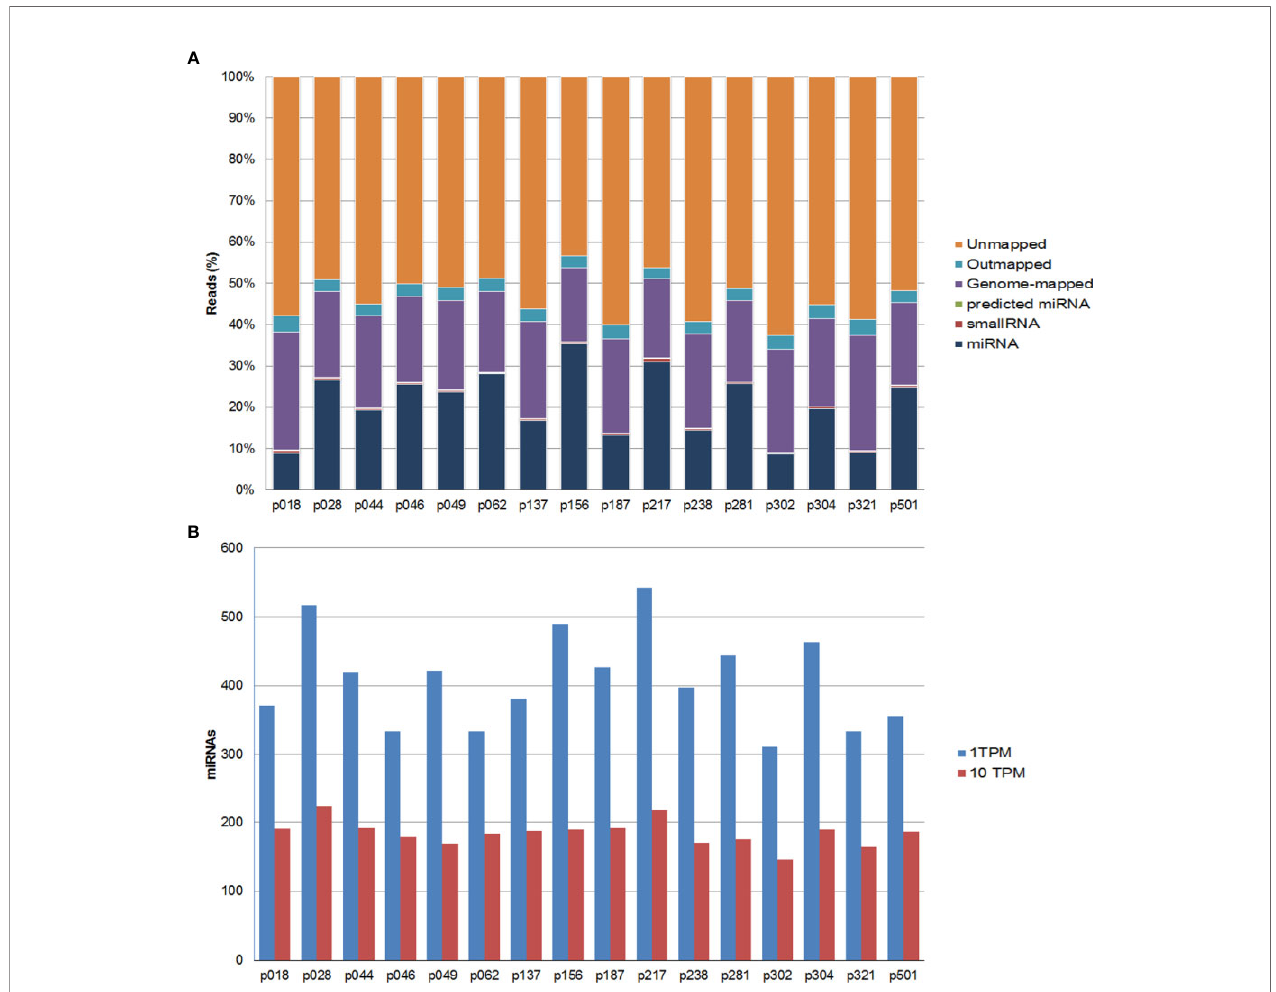
FIGURE 1 | Summary of the mapping results for all samples. (A) Percentage of sequencing reads for each sample. Reads are classi fi ed as miRNAs, small RNAs, genome-mapped, outmapped, high abundance (e.g. rRNA, polyA,mtRNA) and unmapped reads. (B) Number of identi fi ed known miRNAs with transcripts per million (TPM) normalized numbers of counts >1 (blue bars) or >10 (red